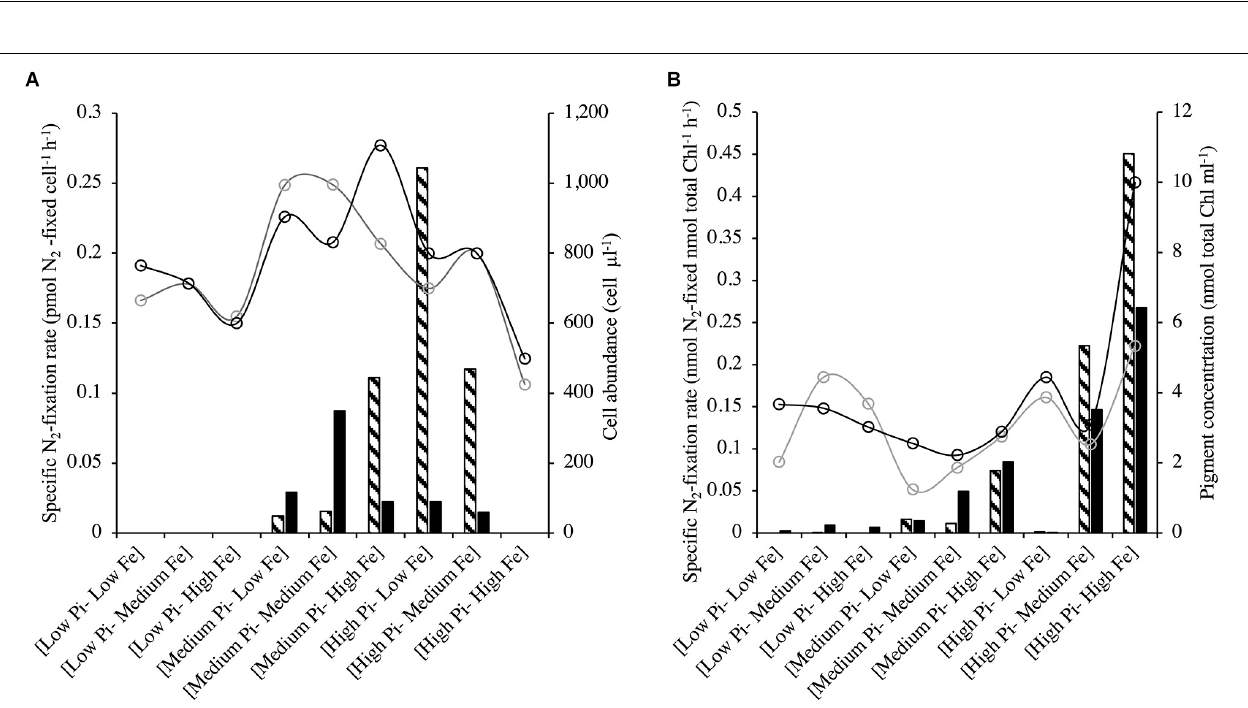
FIGURE 4 | Monod curves (A) at different PO 43 − concentrations for Halothece sp. and Fischerella muscicola in function of NO 3 − initial levels and (B) at different Fe concentrations for Halothece sp. (under [Low NO 3 − ]) and F. muscicola in function of PO 43 − initial levels. PO 43 − is represented as Pi.